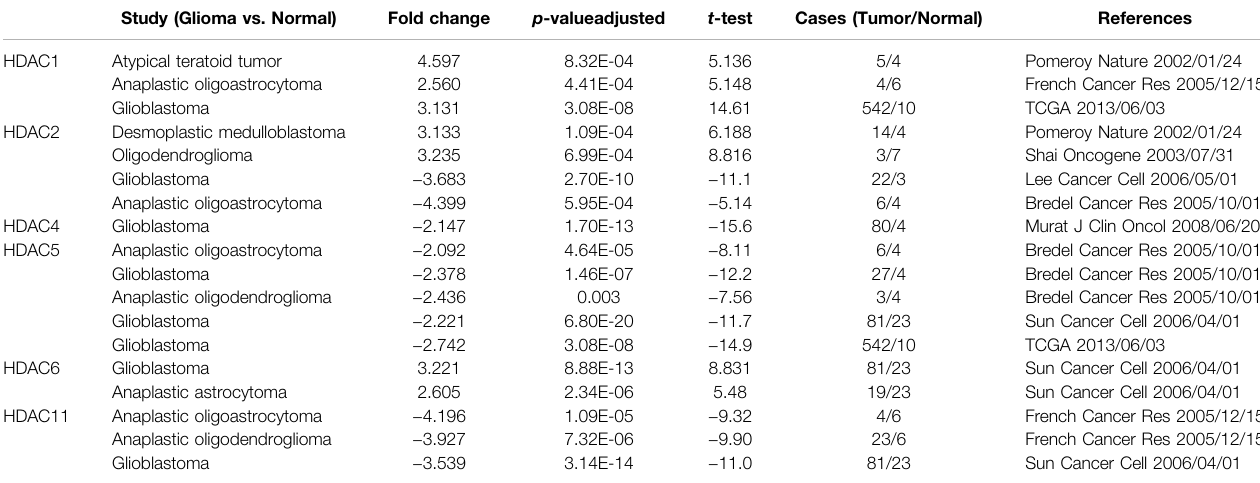
TABLE 1 | Studies on HDAC family in ONCOMINE. Study (Glioma vs. Normal) Fold change p